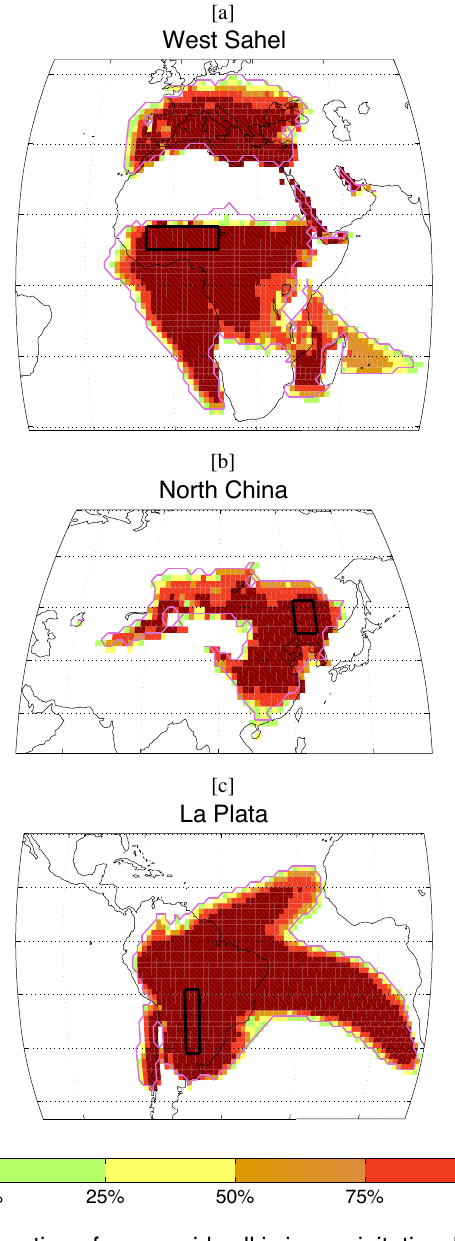
Figure 4. The persistence of the western Sahel, northern China, and La Plata precipitationsheds for ERA-I, for the years 1980–2011. “Significant” is defined as greater than 5mmgrowingseason − 1 , and the dark red areas correspond to the core precipitationshed , with significant contribution occurring during 100% of growing seasons. The black boxed areas are the sink regions for each precipitation- shed.